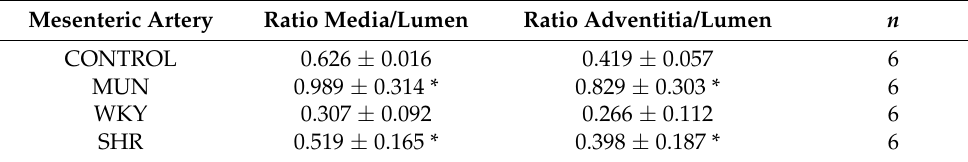
Table 2. Vascular wall morphology changes associated with hypertension.